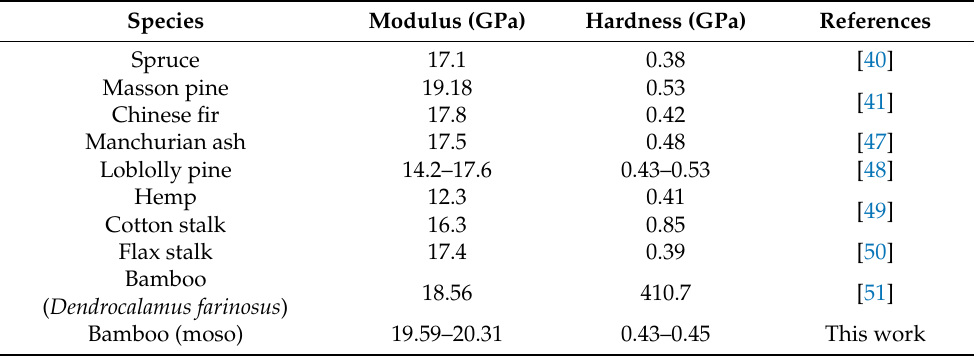
Table 1. Fiber cell wall mechanical properties of different materials